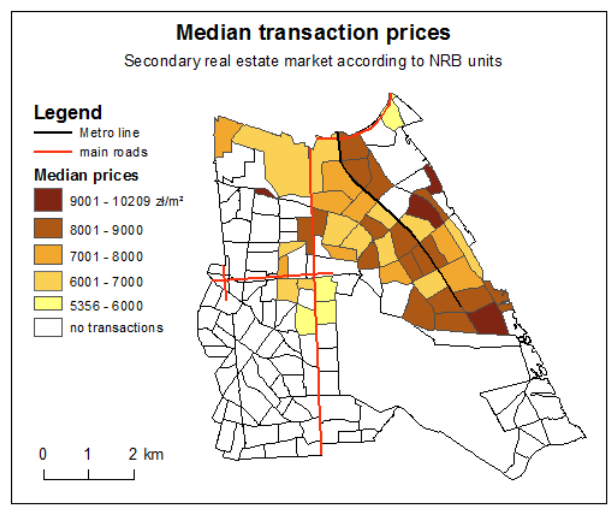
Fig. 6. Average prices of residential premises on the secondary real estate market in Ursynów, according to cadastral